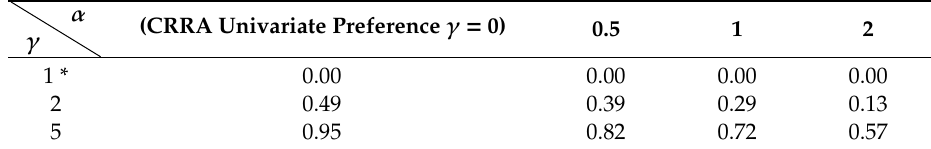
Table 2. The US optimal investment weights in the US market with Abel’s bivariate preferences with empirical data for the period